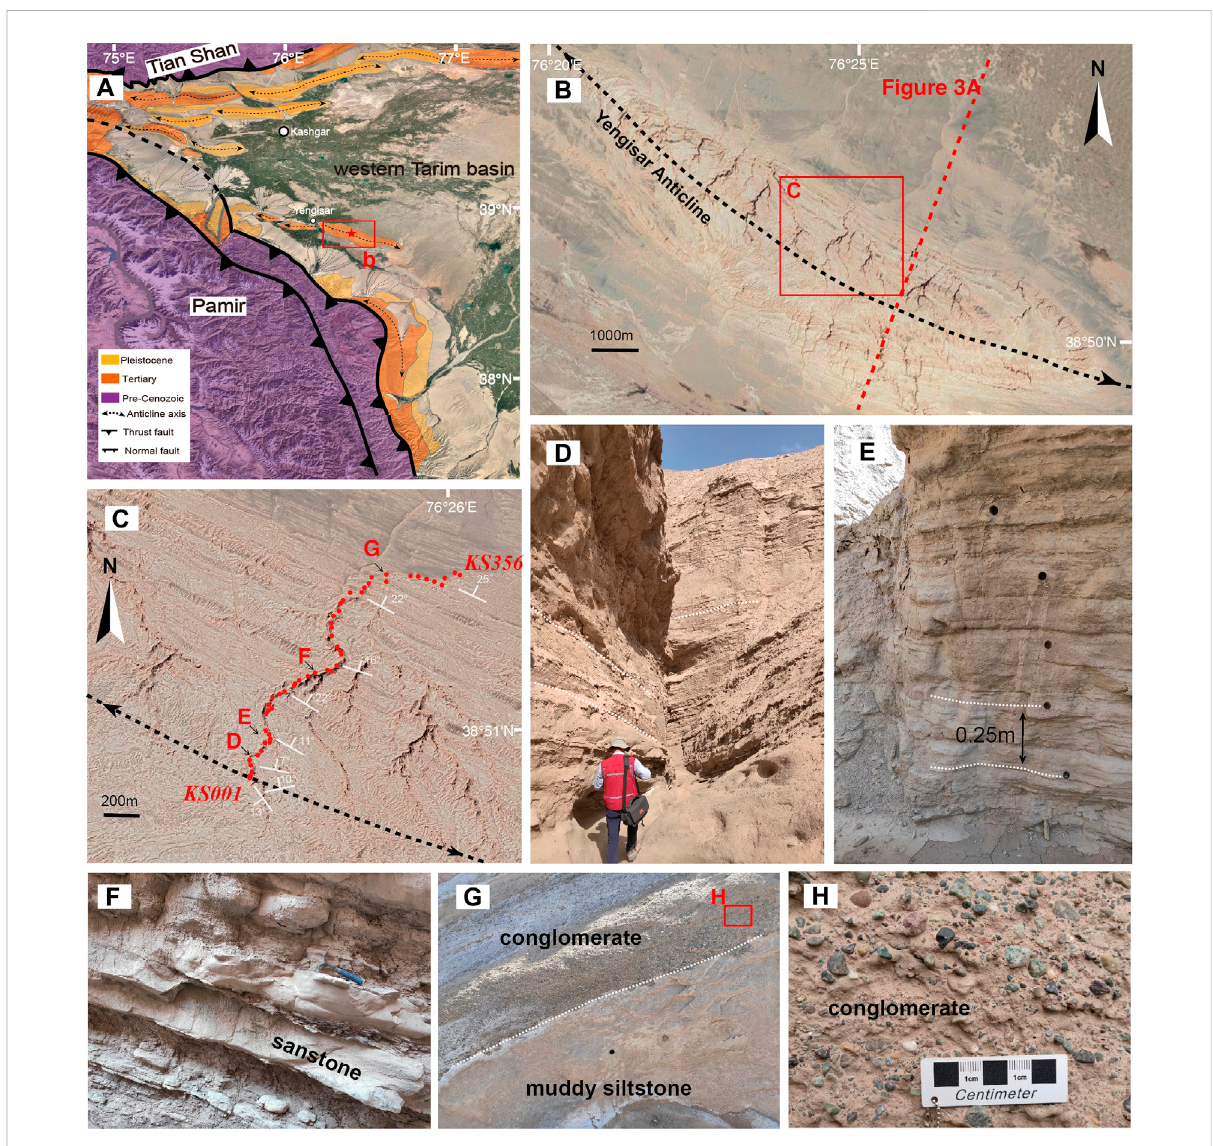
FIGURE 2 (A) Geological sketch map of the study area with highlighting on the Cenozoic strata distribution (after Pan et al., 2009). The red aster denotes the location of the studied section. (B) and (C) show thedetailed sampling sites along the canyonacross the northeast limb of the Yengisar anticline. (D) , (E) , (F) , (G) , and (H) show the stratigraphy, lithology and sampling snapshot in the fi eldwork, the spots for photography are marked in (C)